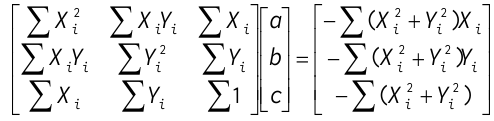
Equation 3. “Equation of circular distribution on a saw blade milling cutter”.